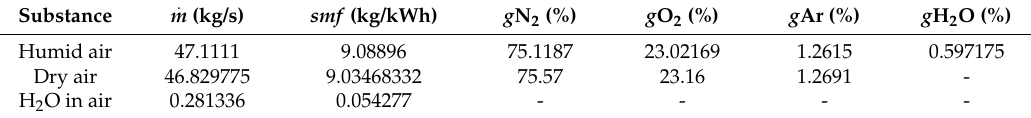
Table 4. Air consumption and mass composition at 100% SMCR, ISO